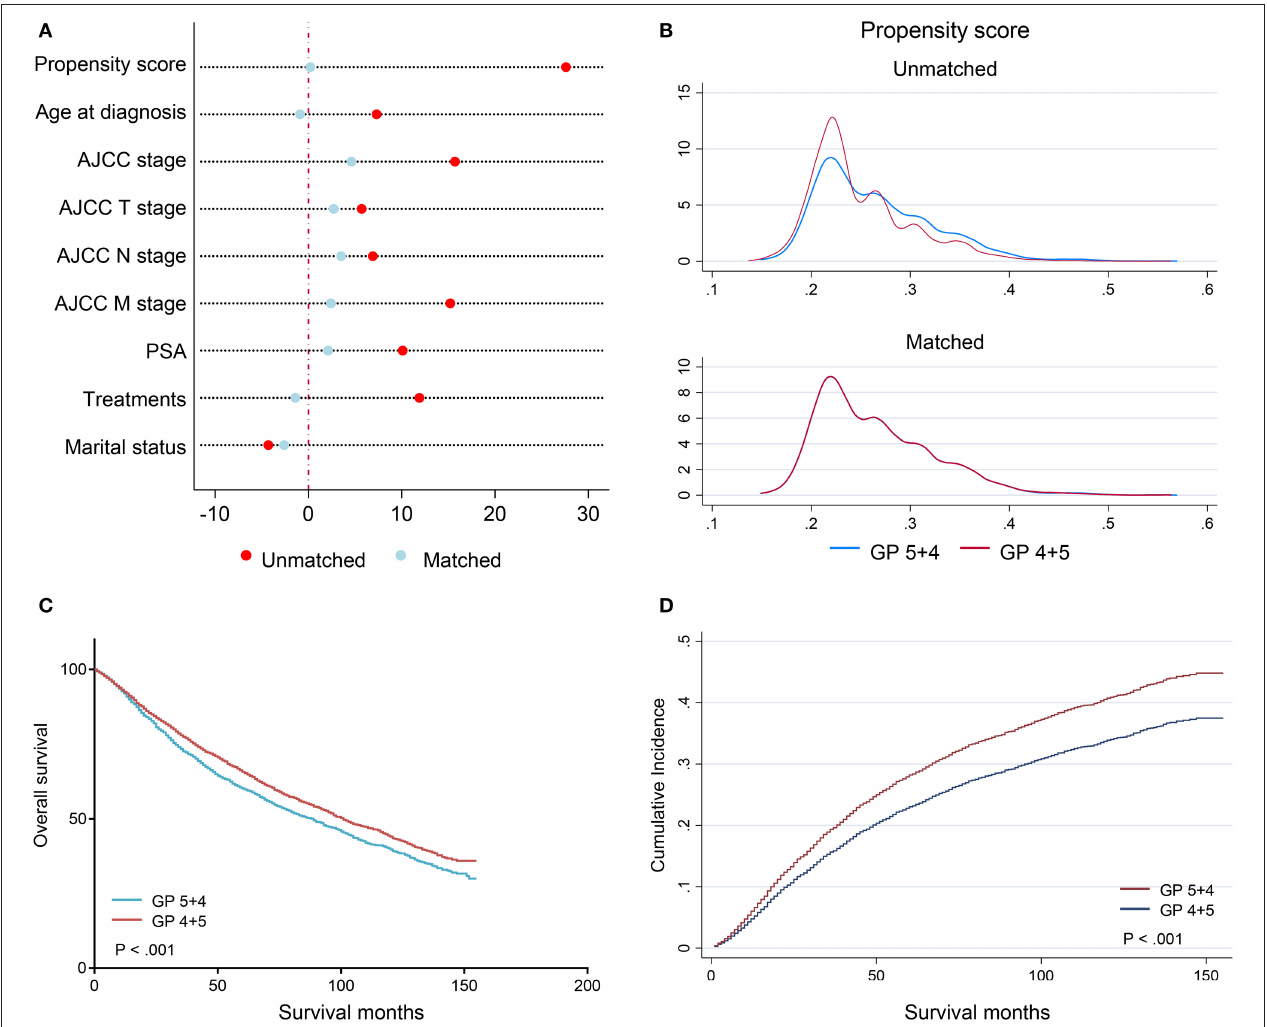
FIGURE 2 | Plots after PSM in a 1:1 ratio. (A) the love-plot (dot chart) of the standardized percentage bias for each covariate before and after PSM; (B) the kernel density plot of propensity score before and after PSM; (C) the Kaplan–Meier curves stratified by Gleason patterns after PSM; (D) the CIF curves stratified by Gleason patterns. PSM, propensity